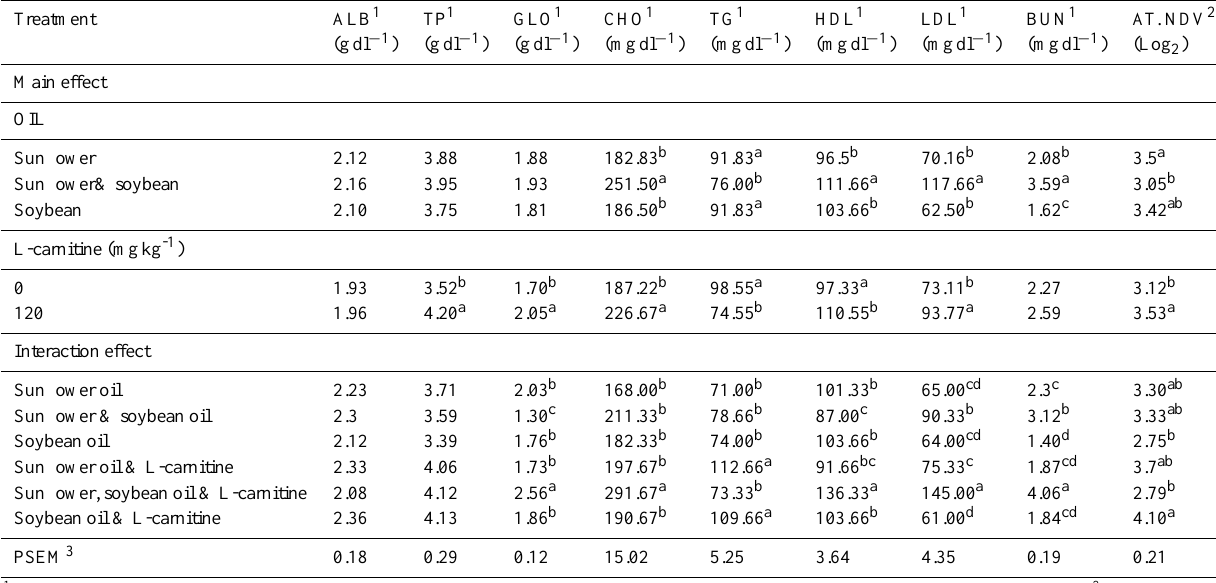
Table 5. Effects of soybean, sunflower oil and L-carnitine supplementation on some blood biochemical parameters of broiler chicks.